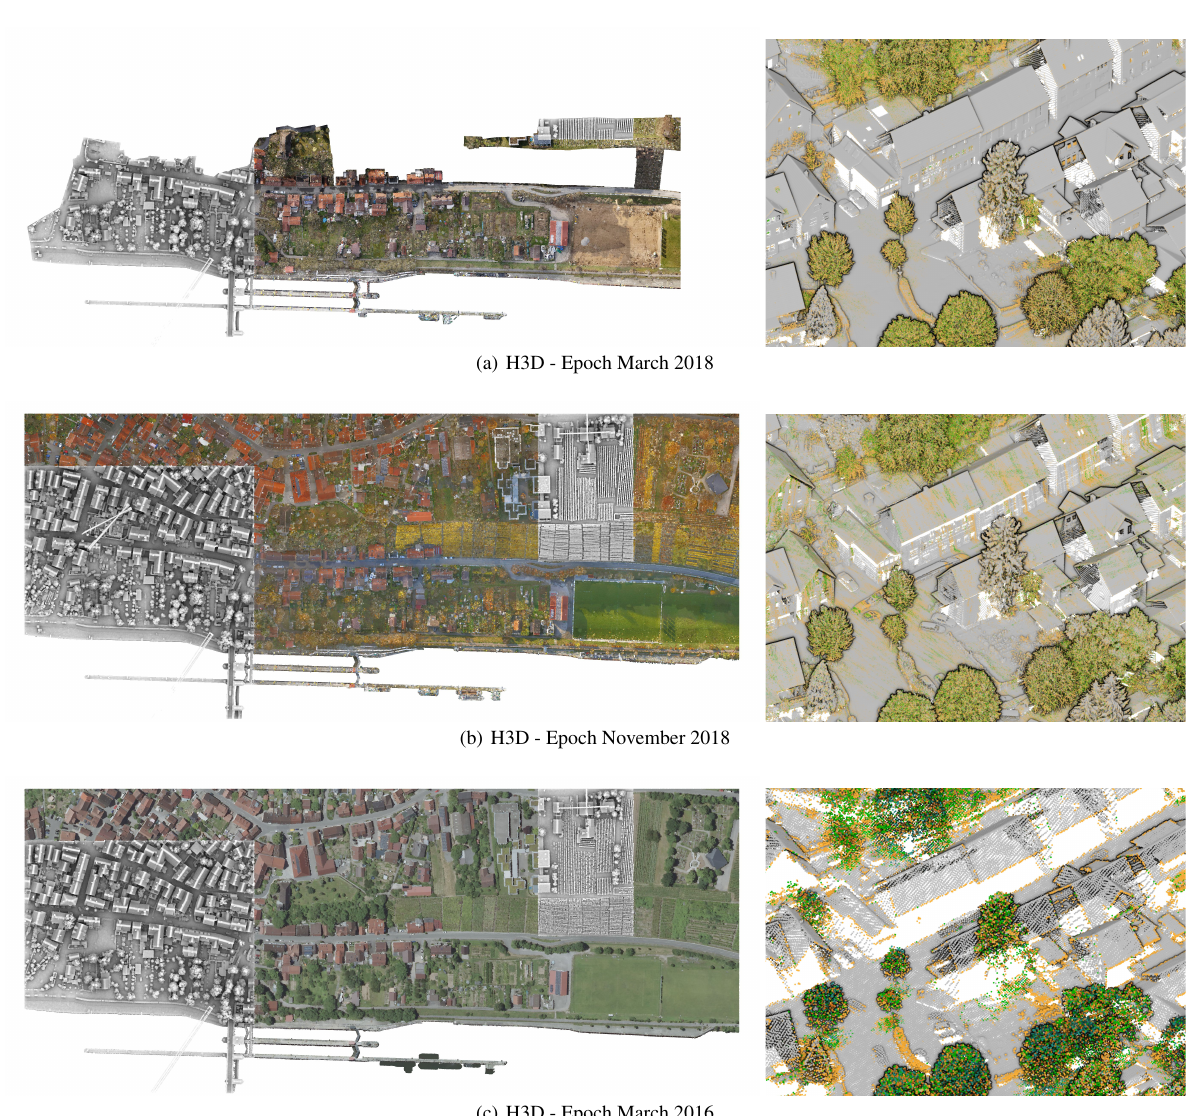
Figure 2. Compilation of our data sets/epochs used for testing our approach. Each visualization depicts an overview of the complete data set, where the training set is colored according to available RGB data while the test set is presented as shading ( left ). Respective close-ups are colorized according to the number of returns of an emitted laser pulse ( right